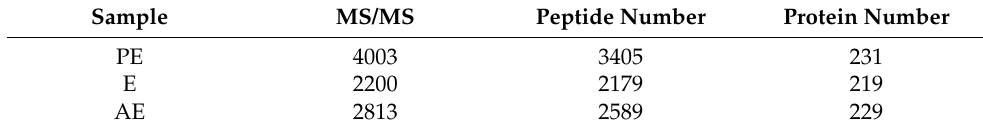
Table 1. Statistics and analysis of salivary protein in different stages of estrus cycle.